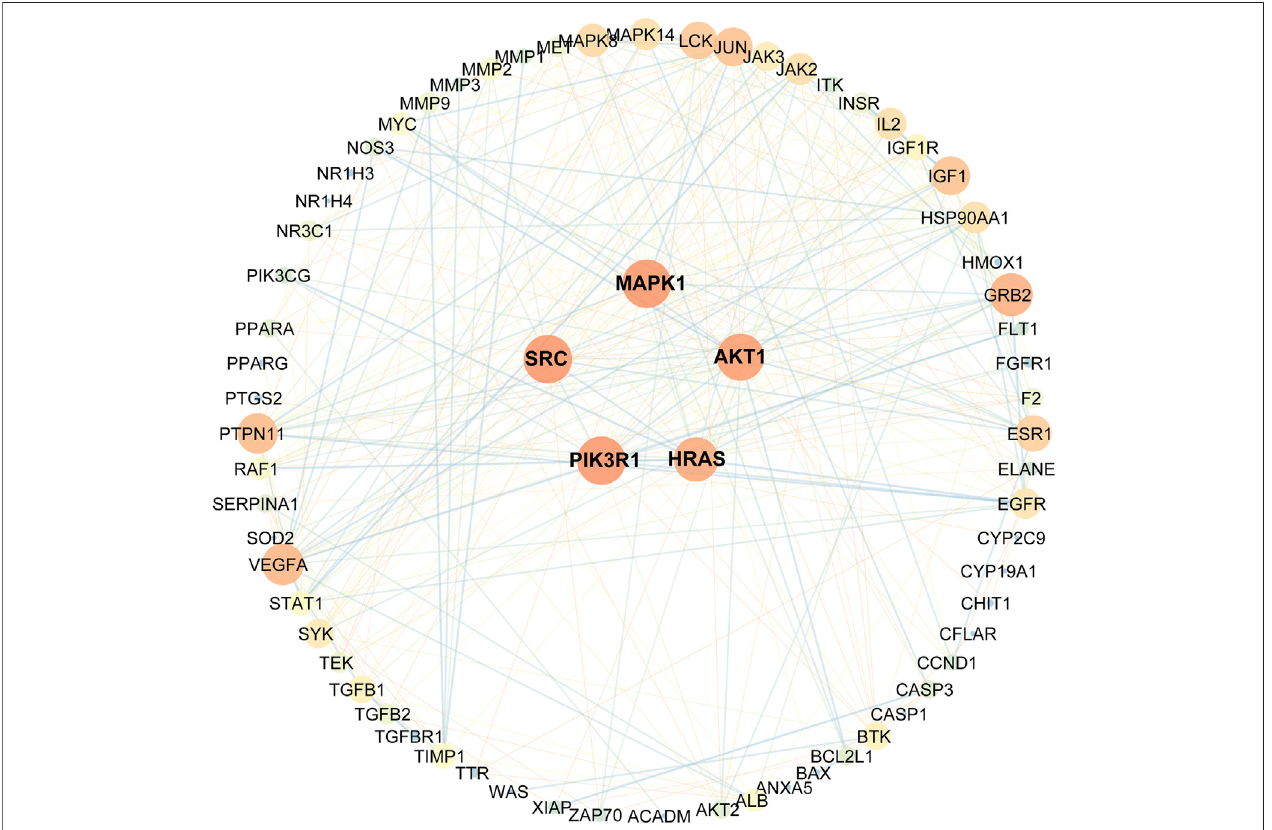
FIGURE 3 | Protein-protein interactions network schematic ofintersection targets of celastrol and AIH. The warm color tone and node size indicate higher degree, the thick red lines indicate closer structure linkage.